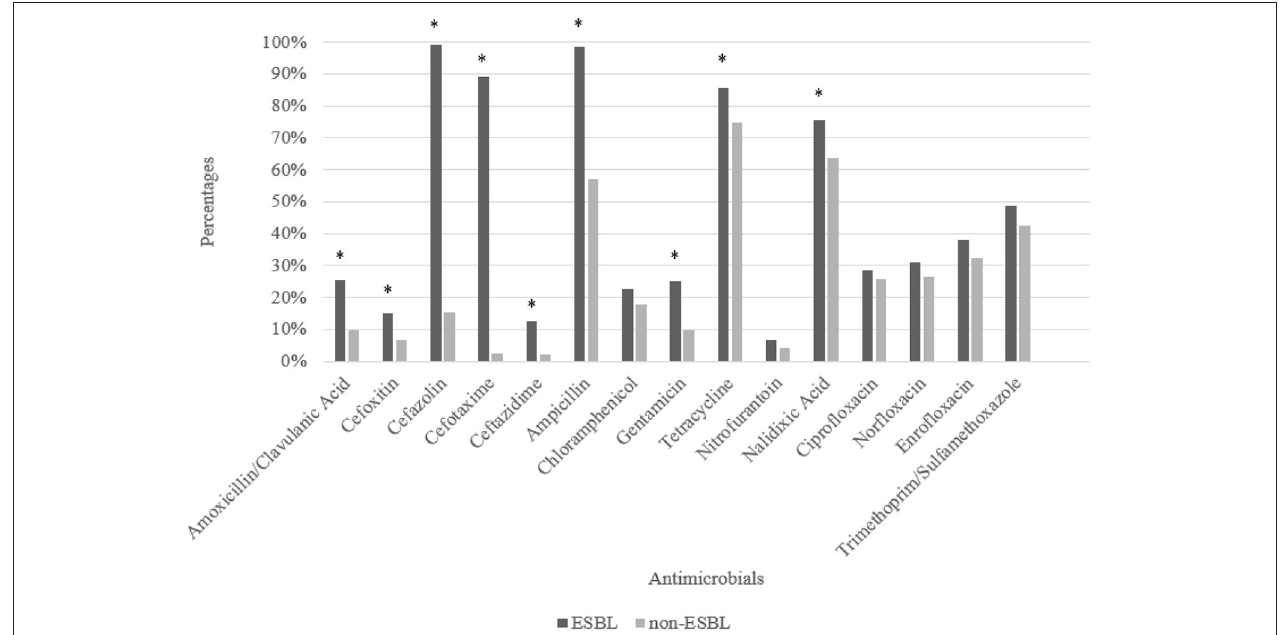
FIGURE 1 | Percentage resistance exhibited by ESBL-producing E. coli strains and non-ESBL-producing E. coli strains isolated from commercial chicken carcasses in southern Brazil from 2013 to 2014. * p < 0.05 by Pearson’s Chi-square test.